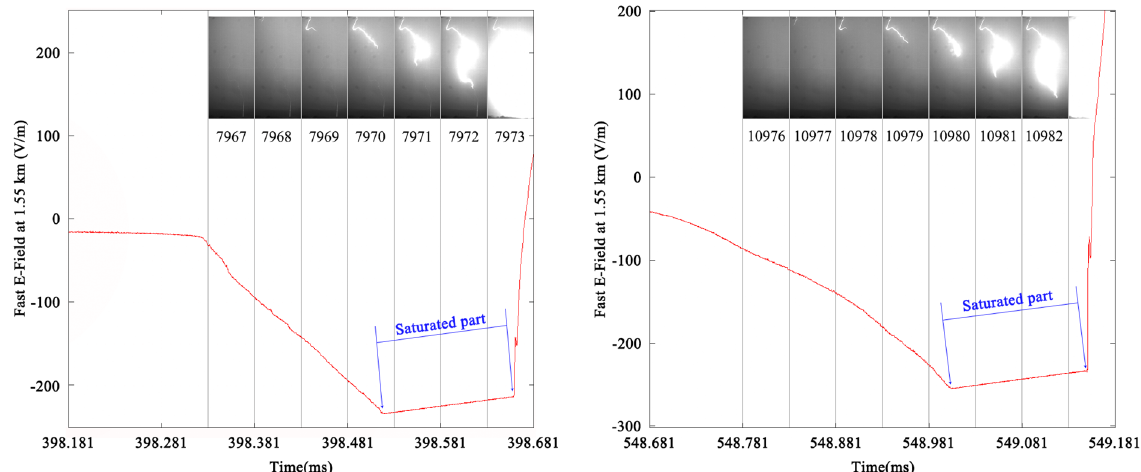
Figure 8. Two examples of acceleration leaders whose propagation result in saturation of both high-speed frames and electric field recorded at 1.55 km. The left one is DL2 and the right one is DL7. The electric field